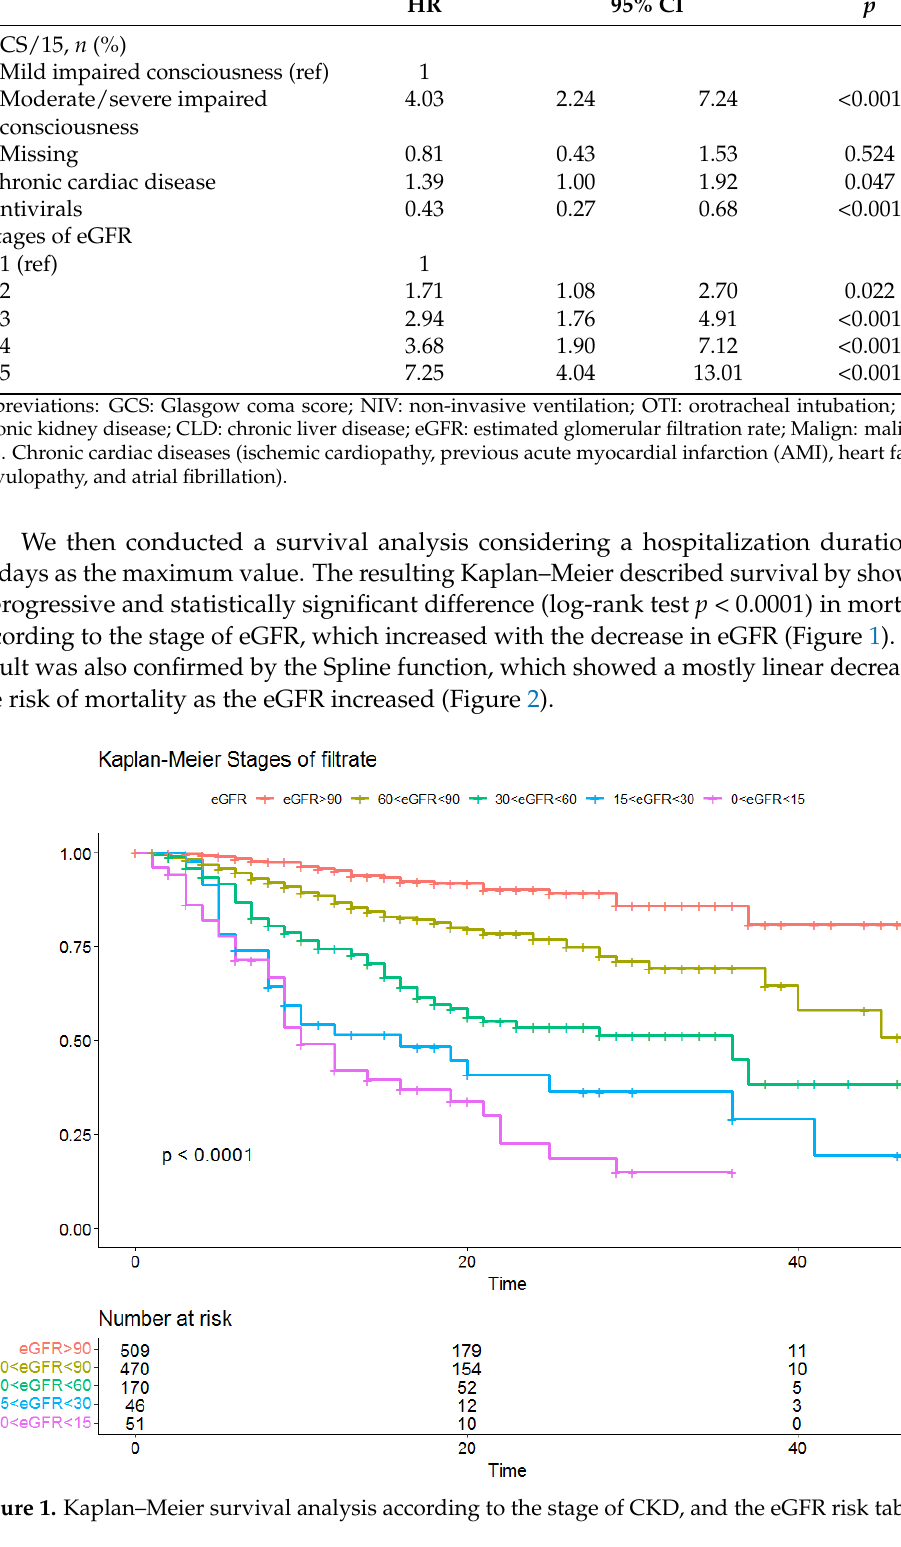
Figure 2. Spline function of the risk of mortality. Red line: Log hazard value; Dotted yellow lines: Confidence interval values.